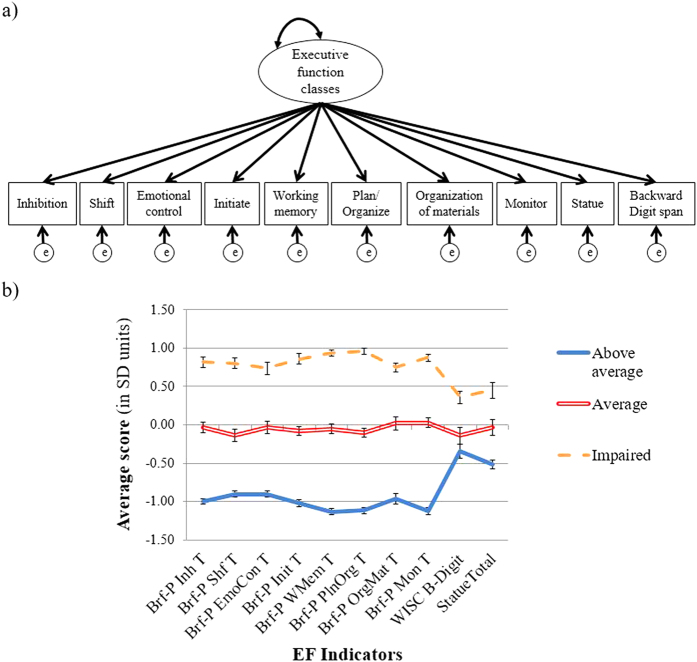
Latent Profile Analysis model and results.(a) The latent profile analysis had 10 indicators of executive function and (b) yielded three EF classes: “Above average”, “Average”, and “Impaired.” The three EF classes differed on their scores across the indicators. Scores are in standard deviation units based on data from the present sample. The WISC Backward Digit span and Statue Total were reverse-scored such that for all indicators, higher scores indicate greater impairment. Note for panel b: All EF indicators had a significant difference between Above average, Average, and Impaired groups except the WISC B-Digit, which only had a difference between Above average/Impaired groups and Average/Impaired groups. Brf-P Inh T: BRIEF-Parent report inhibition T-score; Shf T: Shift T-score; EmoConT: Emotional Control T-score; Init T: Initiate T-score; WMem T: Working memory T-score; PlnOrg T: Plan/Organize T-score; OrgMat: Organization of Materials T-score; Mon T: Monitor T-score; WISC B-Digit: Wechsler Intelligence Quotient for Children IV Backward Digit span scaled score (reverse scored); Statue Total: total score on the NEPSY-II statue subtest (reverse scored).